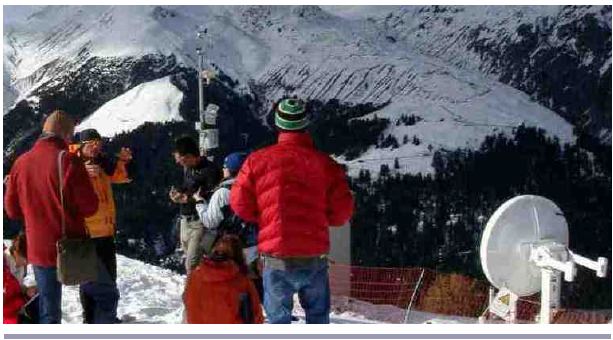
Fig. 3. Diverse measurement technologies and data sets are both needed to understand complex outdoor